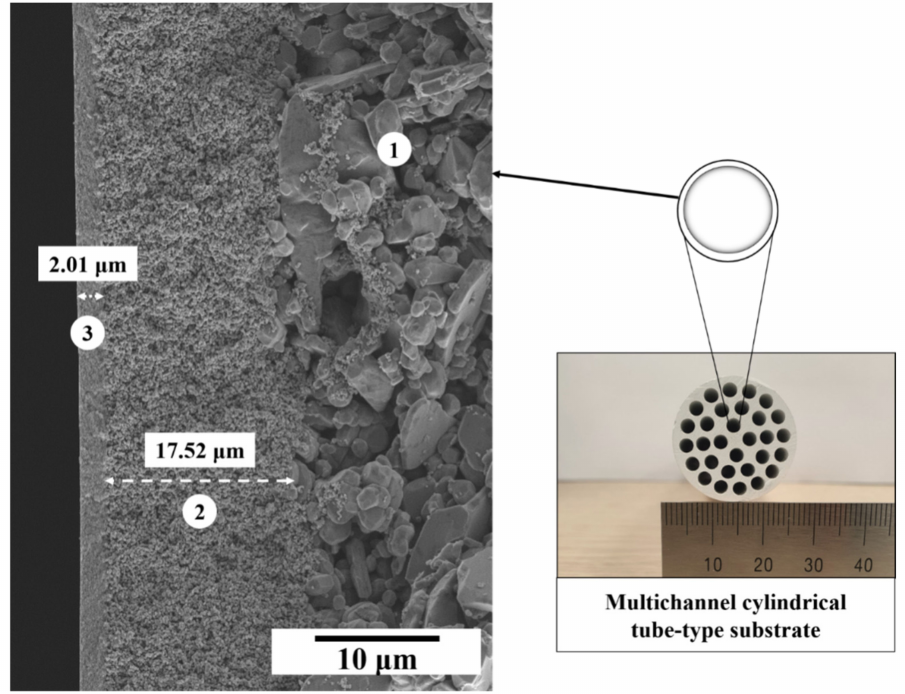
Figure 12. Cross-section of the asymmetric multichannel cylindrical tube-type substrate; (1) macrop- orous support, (2) intermediate microfiltration layer, (3) top α -Al 2 O 3 ultrafiltration